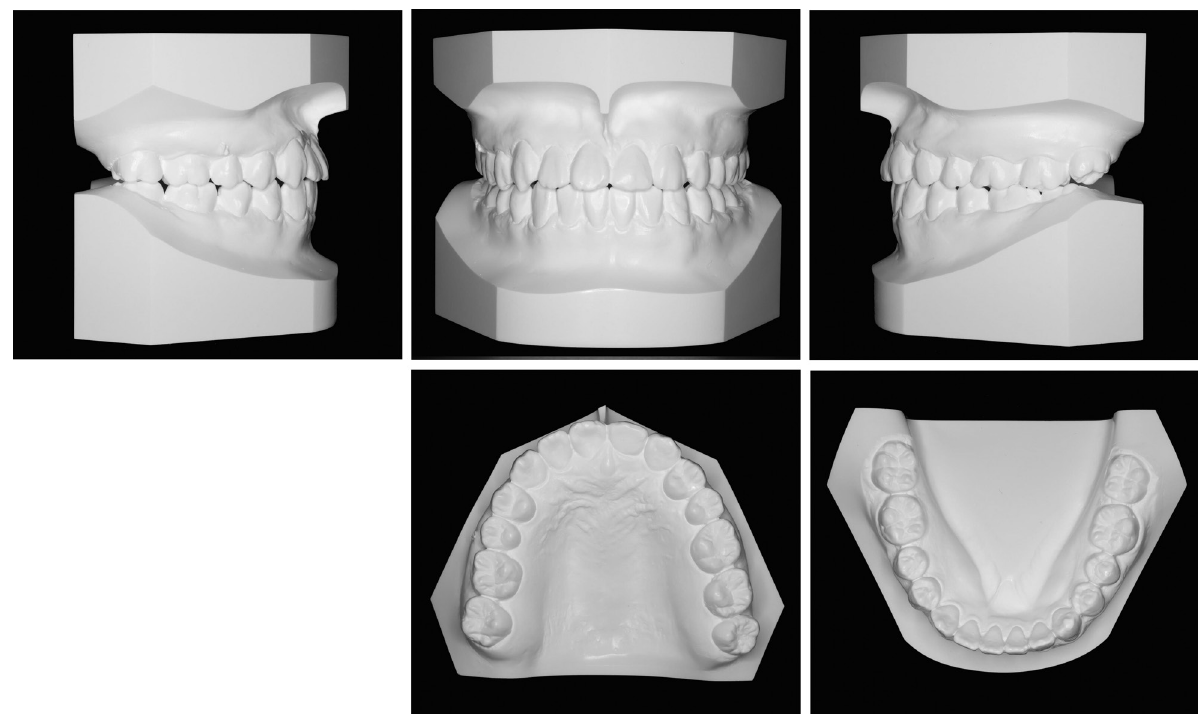
Figure 7. Posttreatment dental